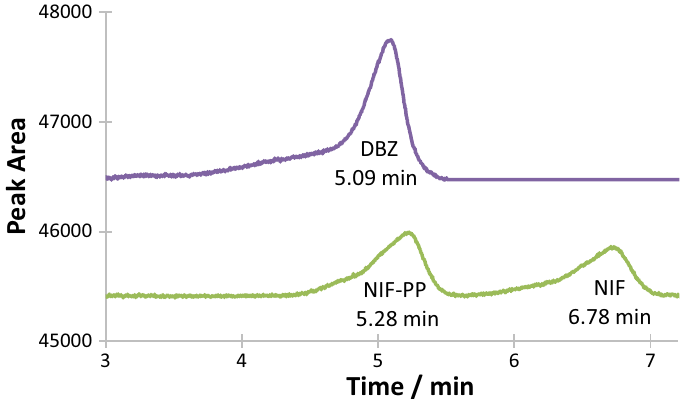
Figure 2. HPLC-Chromatograms of Dacarbazine and Nifedipine measured at absorption wavelengths of 330 and 326 nm, respectively. Note that the photoproduct, DBZ-PP, does not absorb at 330